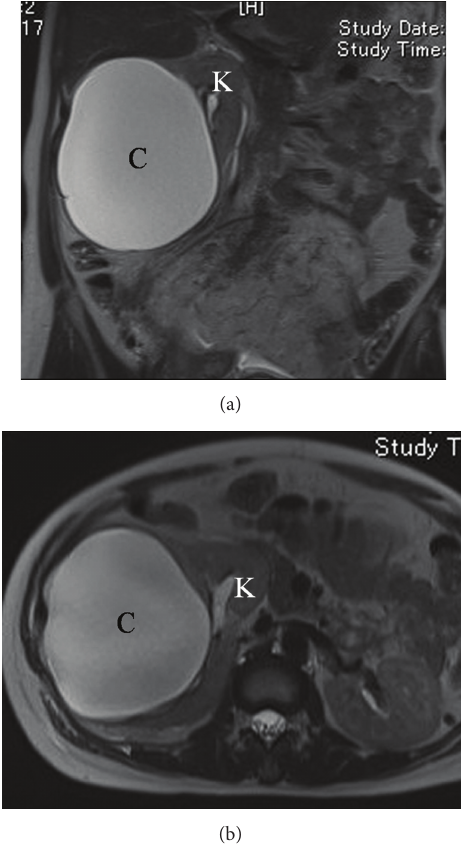
Figure 2: Magnetic resonance imaging (T2-weighted image) of a large cystic mass arising from the lower pole of the right kidney. (a) Coronal and (b) axial view. C, cystic mass; K, right